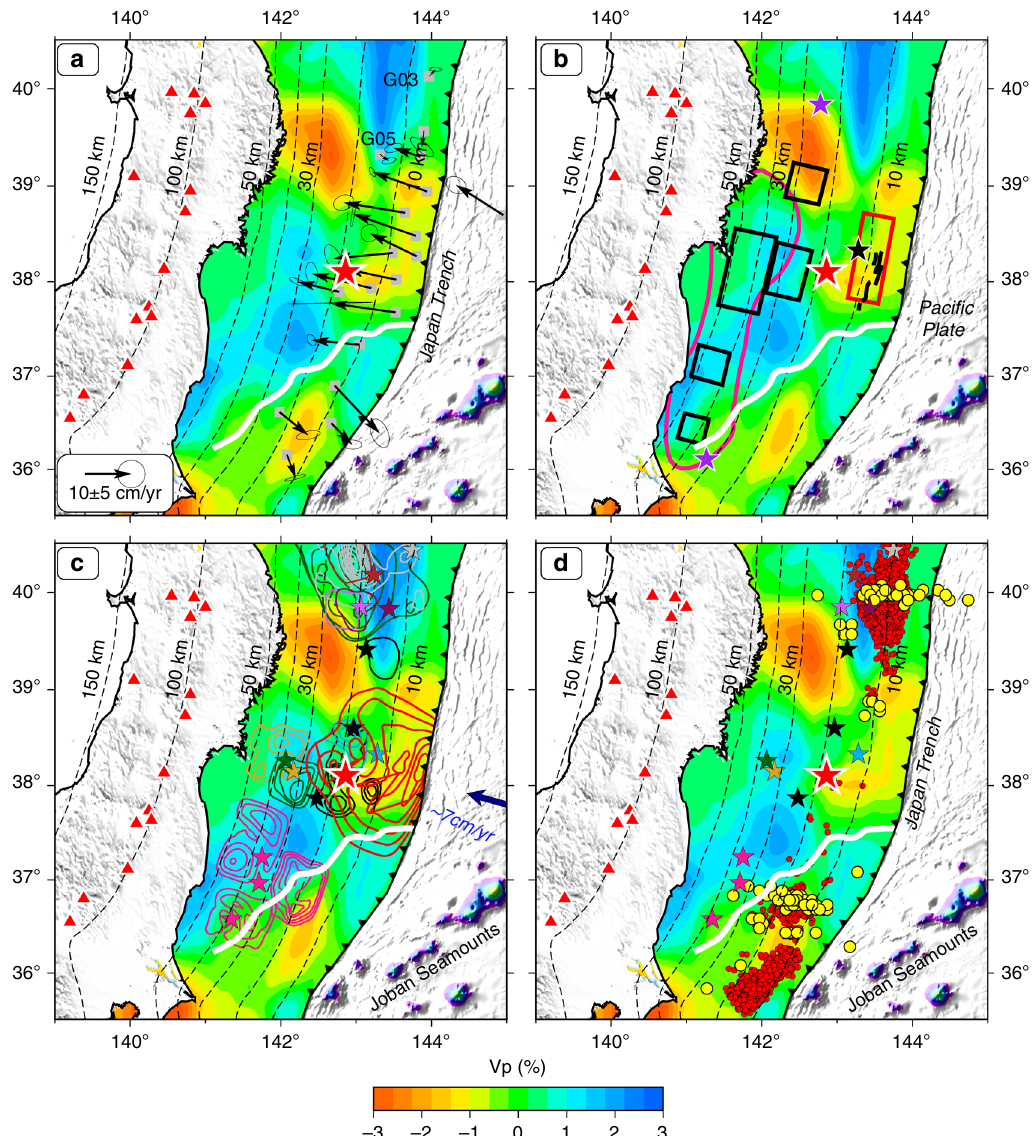
Fig. 2 Vp tomography and characteristics of the great 2011 Tohoku-oki earthquake. The colors in a – d show residual Vp tomography along the upper boundary of the subducting Paci fi c plate (black dashed lines) obtained by this study, and the big red star denotes the mainshock epicenter of the great 2011 Tohoku-oki earthquake (Mw 9.0). a The black arrows show postseismic displacement rates with 1 σ error ellipses estimated by Tomita et al. 44 whose observation periods were from September 2012 to May 2016. b The fi ve black rectangles denote locations of coseismic strong ground motions 34 . The magenta contour line marks the site of coseismic high-frequency P-wave radiation with a relatively low seismic moment during the 2011 Tohoku-oki earthquake 37 . The red rectangle denotes a slow slip event (M 7.0) preceding the 2011 Tohoku-oki earthquake 36 . The black short lines denote normal faults near the Japan trench. c The red contour lines near the trench denote the coseismic slip distribution of the 2011 Tohoku-oki earthquake 53 . Other color lines and small stars show coseismic slip distributions and epicenters of large megathrust earthquakes 54 ( M ≥ 7.0) that occurred during January 1900 to February 2011. d The red and yellow dots denote epicenters of tremors and very low-frequency earthquakes (VLFEs), respectively 22 . The color stars in d are the same as those in c